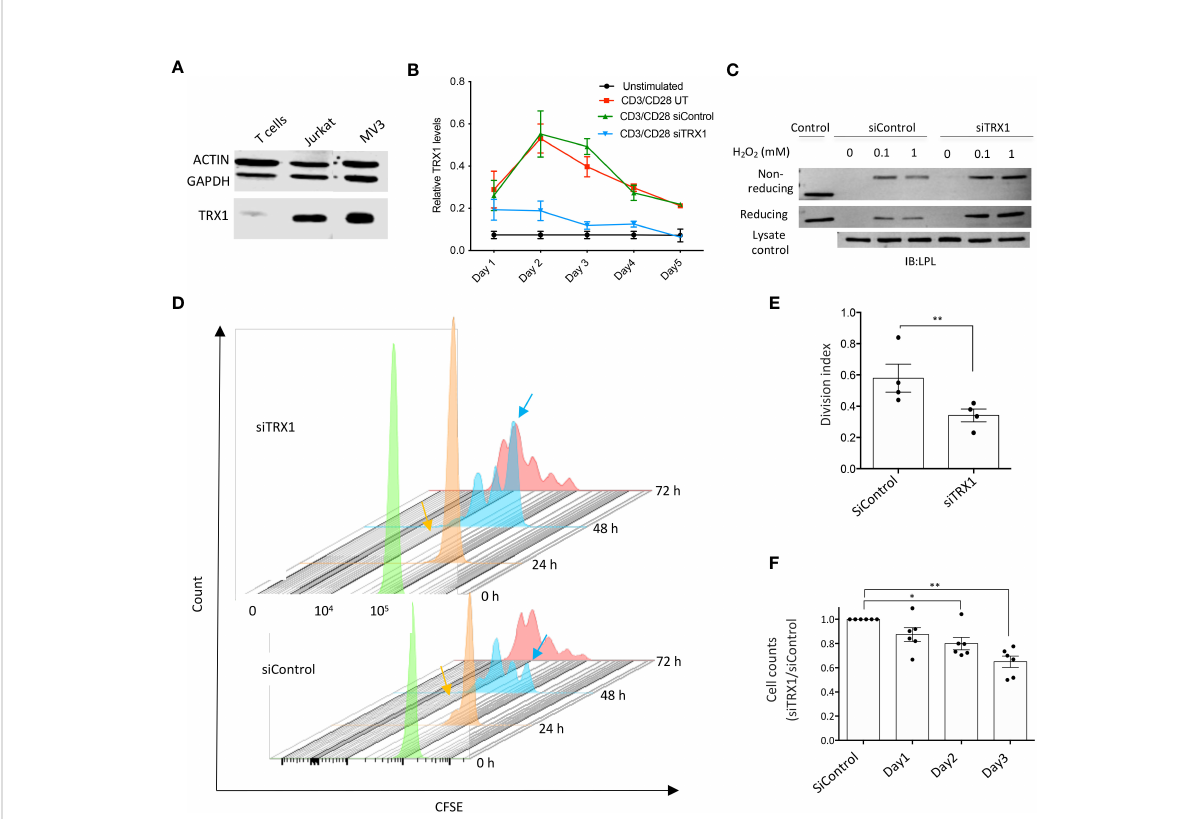
FIGURE 1 TRX1 is pivotal for redox homeostasis and T cell proliferation. (A) Representative immunoblot showing TRX1 levels in PBTs, MV3 cells, and Jurkat lymphoma cells. Lysates (20 µg) were loaded in each lane. Actin and GAPDH were used as loading controls (n = 3). (B) Kinetics of TRX1 expression in PBTs. PBTs were nucleofected with control or TRX1-speci fi c siRNA and activated with plate-bound anti-CD3/anti-CD28 antibodies for up to 5 days. TRX1 expression was assessed by fl ow cytometry (n = 4). (C) Representative immunoblots showing TRX1-trapping oxidized LPL in peripheral blood T cells (PBTs). PBTs nucleofected with control or siTRX1-speci fi c siRNA were treated with the indicated concentrations of H 2 O 2 3 days after activation, and trapping was performed (n = 3). (D) Proliferation of untransformed human PBTs over 3 days. Cell proliferation is indicated by diminished intensity of CFSE fl uorescence per cell. Mean fl uorescence intensity of CFSE on: 0 h (green), 24 h (orange), 48 h (light blue), and 72 h (red) is shown. Orange and light blue arrows indicate once-divided and undivided PBT populations at 24 and 48 h in the siControl and siTRX1 groups, respectively. (E) Division indices of control (siControl) or TRX1-speci fi c (siTRX1) siRNA-transfected PBTs after 72 h. (F) Ratio of cell counts in siTRX1 and siControl transfected cells over 3 days. Data represent mean ± SEM (n ≥ 3; * p < 0.05, ** p <